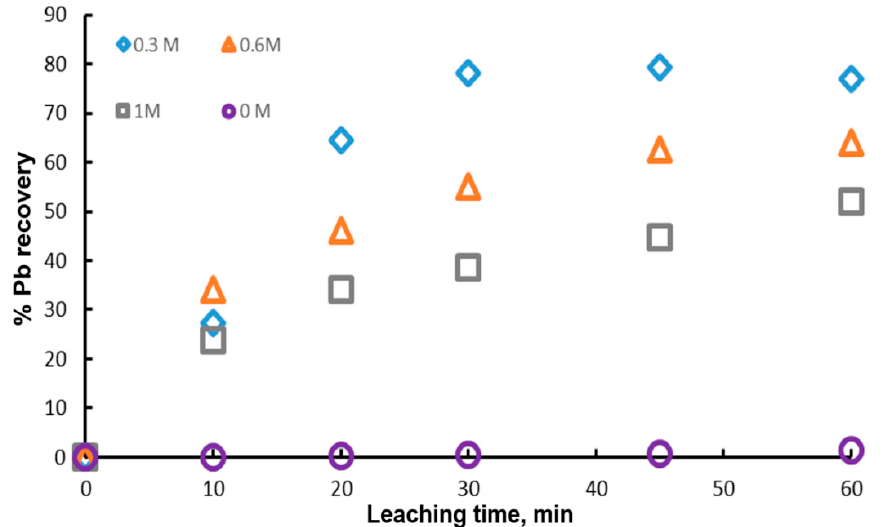
Figure 5. Effect of the initial concentrations of citrate ion on lead dissolution from pure galena at 20 ◦ C. Experimental conditions: particle size: − 149/+74.1 g of mineral, 0.1 L of solution, 0.3–1.0 M Na 3 Cit, 0.6 M H 2 O 2 .